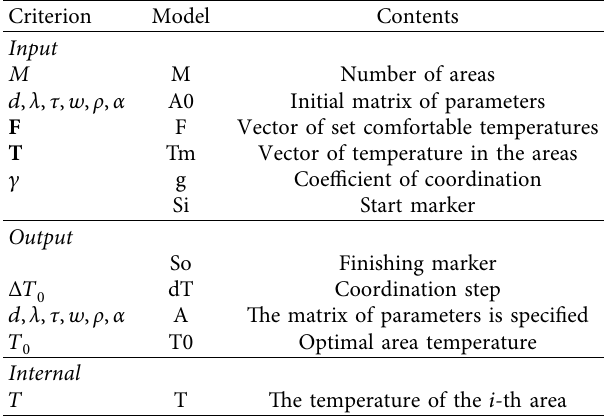
Table 1: Correspondence of the symbols of the analytical and simulation models.